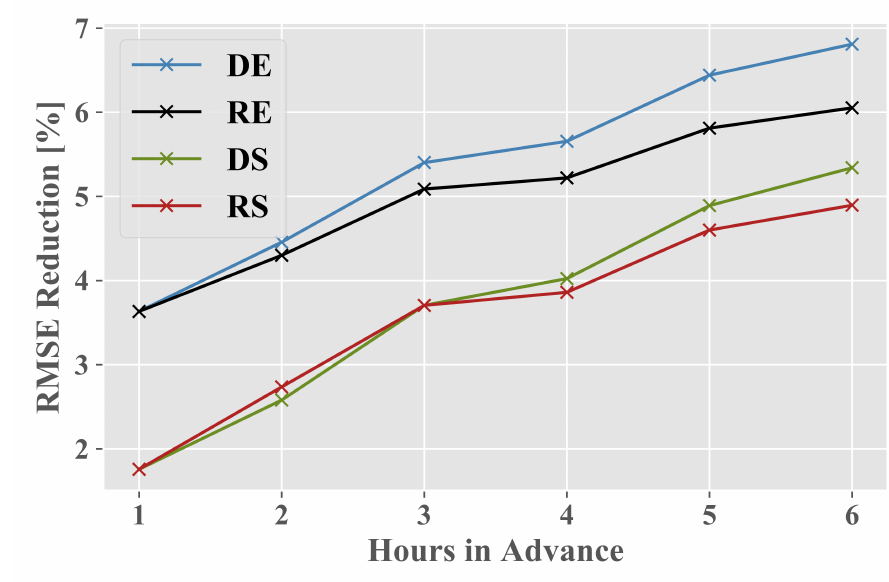
Figure 4. Reduction in root mean squared error (RMSE) obtained by all four models compared to the persistence model at the FINO1 site. Blue, black, green, and red lines denote the direct error (DE), recursive error (RE), direct standalone (DS), and recursive standalone (RS) strategies,